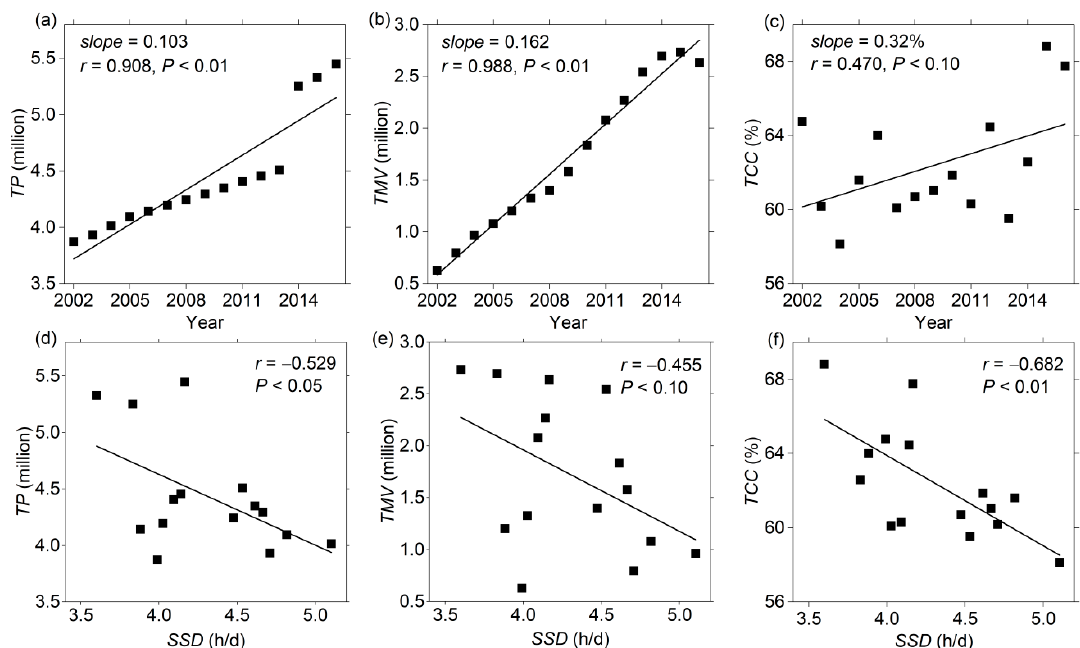
Figure 6. Variations in ( a ) total population ( TP ), ( b ) the total number of motor vehicles ( TMV ), and ( c ) total cloud cover ( TCC ) from 2002 to 2016 in the urban district of Hangzhou City and relationships ( d ) between TP and sunshine duration ( SSD ), ( e ) between TMV and SSD , and ( f ) between TCC and SSD